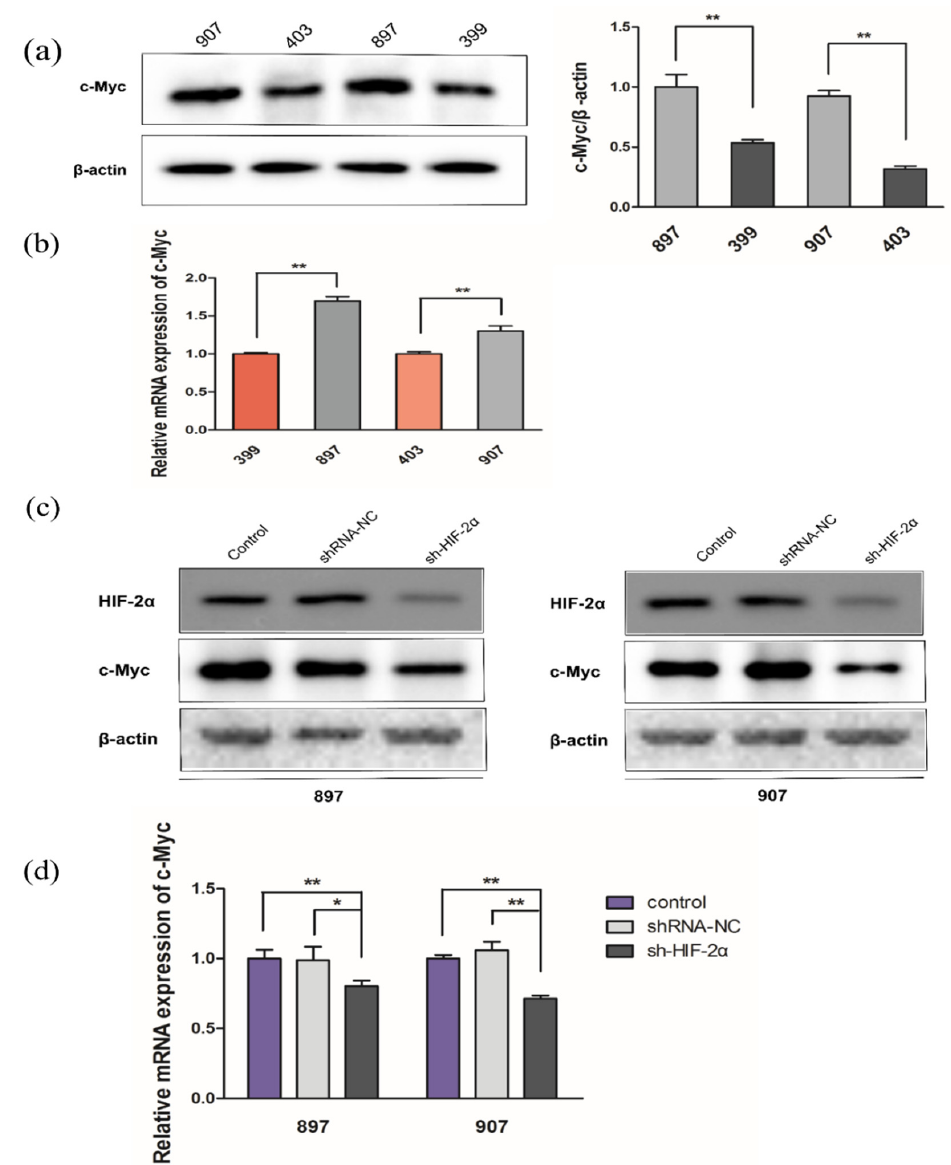
Figure 2. Kras G12D -LOH induces HIF-2 α -dependent c-Myc activation. ( a ) Relative protein expression of c-Myc in Kras G12D -LOH pancreatic ductal adenocarcinoma (PDAC) cells (897 and 907 cells) and Kras G12D PDAC cells (399 and 403 cells). ( b ) Relative mRNA expression of c-Myc in Kras G12D -LOH PDAC cells (897 and 907 cells) and Kras G12D PDAC cells (399 and 403 cells). ( c ) Relative protein expression of c-Myc in sh-HIF-2 α -transfected Kras G12D -LOH PDAC cells (897 and 907 cells) compared with that in shRNA-NC and control groups. ( d ) Relative mRNA expression of c-Myc in sh-HIF-2 α - transfected Kras G12D -LOH PDAC cells (897 and 907 cells) compared with that in the shRNA-NC and control groups. Data are expressed as the mean ± SD, based on three independent experiments. * p < 0.05; ** p <